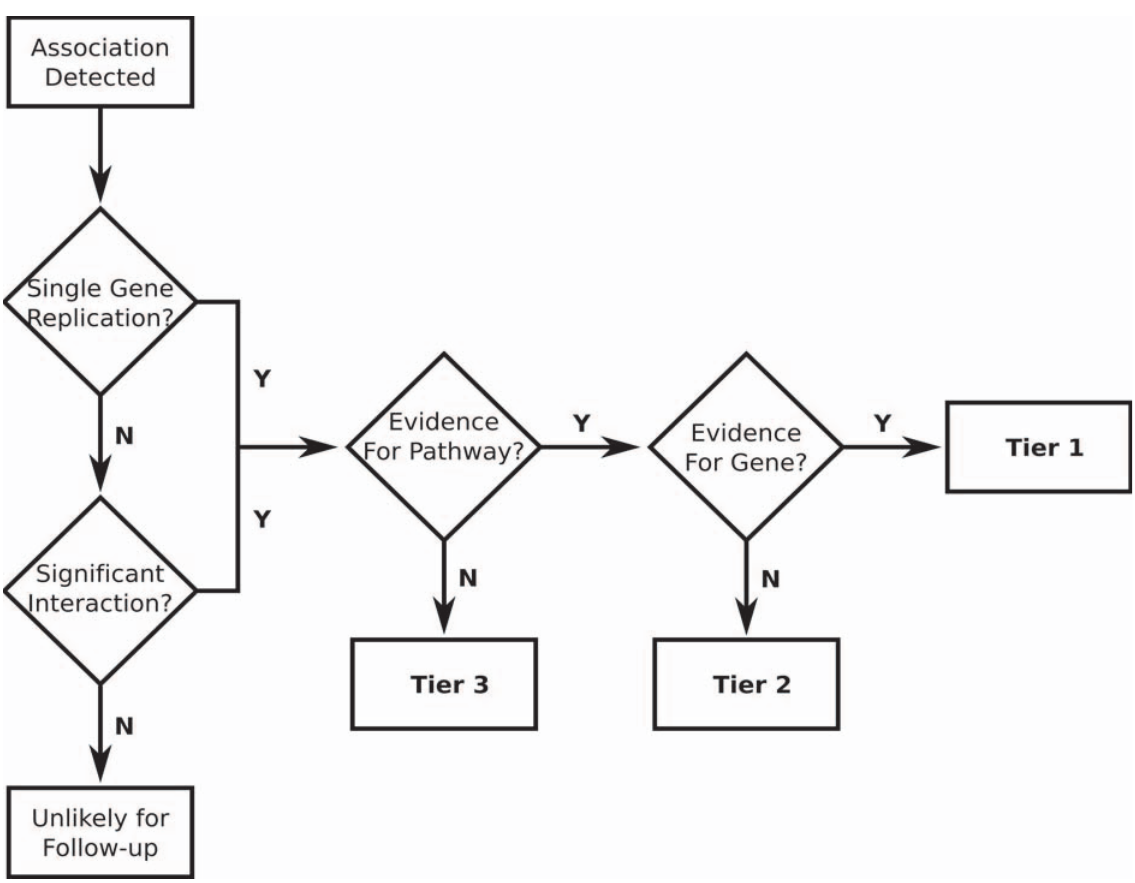
Figure 4. This flowchart represents a method by which candidate SNPs can be divided into tiers for later evaluation based on statistical results and biological information. Tier 1 markers are likely to provide the easiest gene-function studies but provide the least new information. Tier 2 markers have the potential to implicate previously unknown genes in known pathways and are also likely to lead to feasible gene- function studies. Tier 3 markers have the greatest potential to implicate new genes and pathways in the disease process, but gene-function confirmation is likely to be the most difficult for these markers, particularly if clues about role are limited.